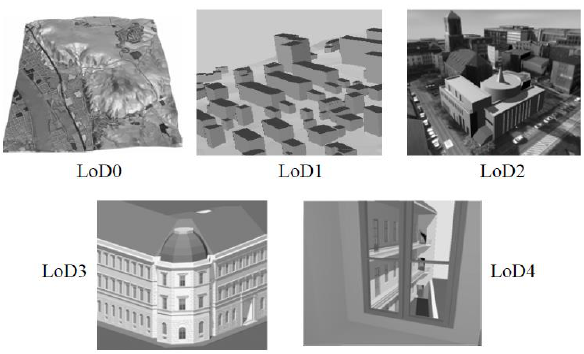
Figure 3. The five level of details (LoD) defined by